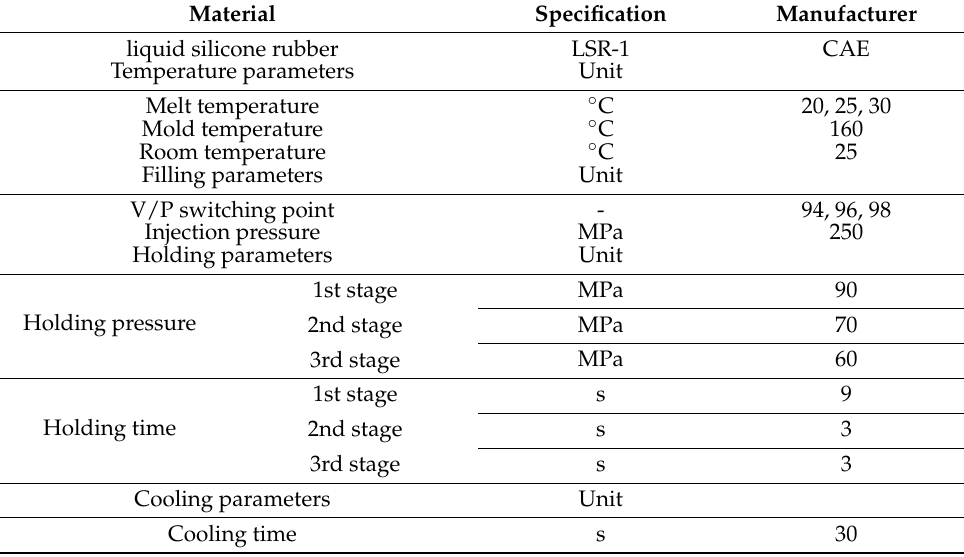
Table 2. Material and Processing Parameters